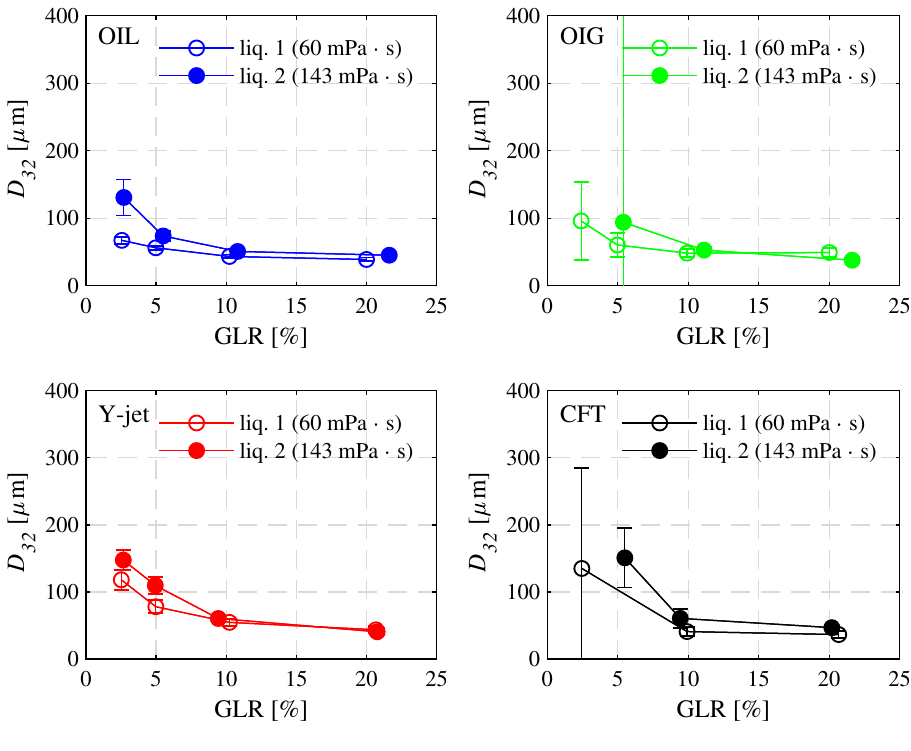
Figure 4. Time-averaged drop sizes.